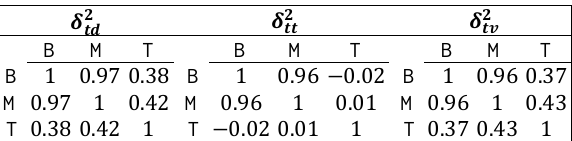
Table 6. Temporal correlation coefficients of each travel indicator (B=bus, M= metro, T= taxi)